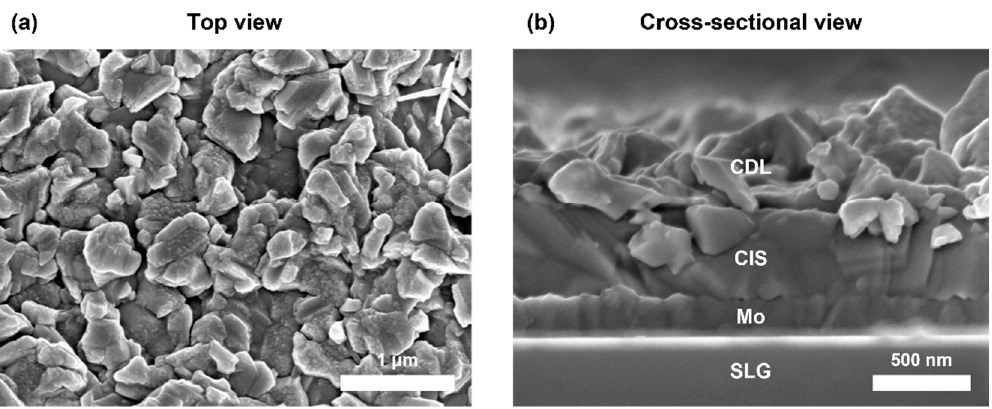
Figure 3. Morphology of MOCVD-prepared CIS layer: ( a ) SEM top-view image; ( b ) SEM cross-sectional image.